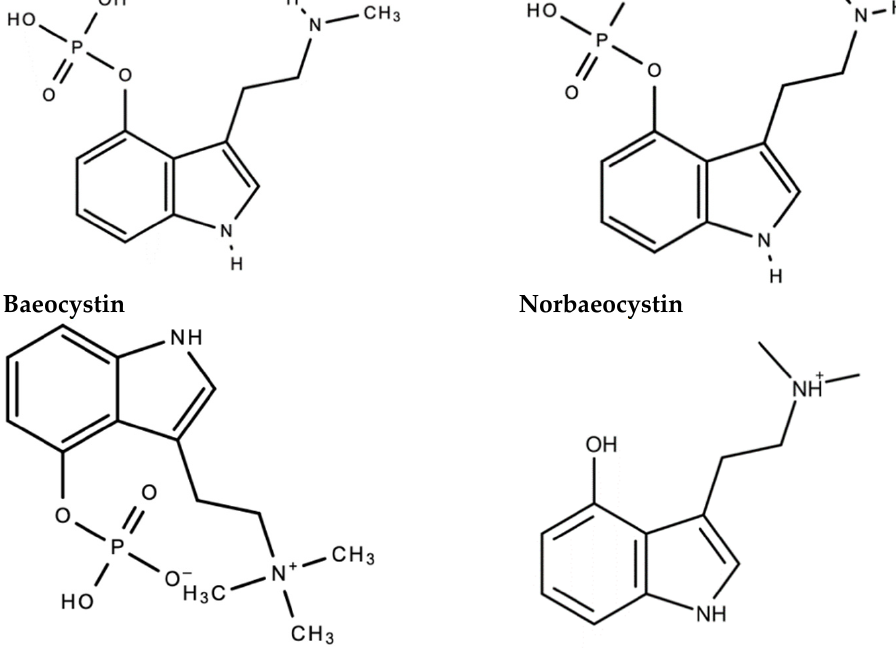
Figure 6. Chemical structures of recently discovered tryptamine derivates that may contribute/enhance the effects of psilocybin and psilocybin-assisted therapy.